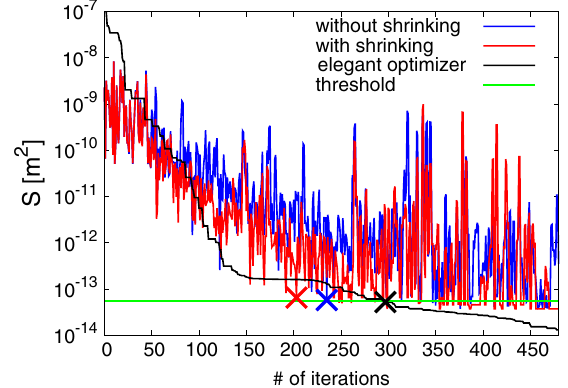
FIG. 15. A representative comparison between the GA simu- lation of 20 generations and 24 individuals without shrinking enhancement (blue) and with (red). Also plotted is the simulation with the ELEGANT simplex optimizer (black). The number of iterations needed for each method to converge to within the predefined threshold S is marked with an (cid:5) of corresponding